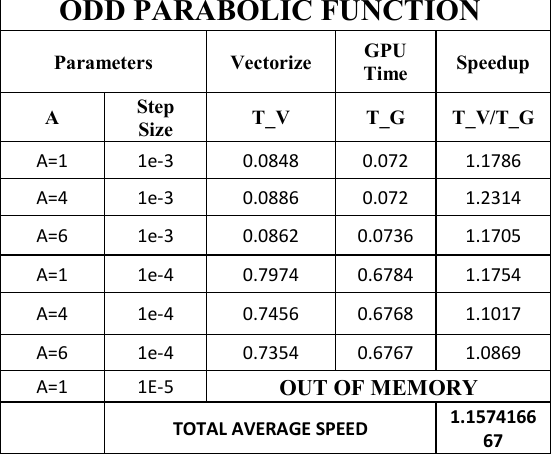
Table 7. : Speedup Time for Odd Parabolic